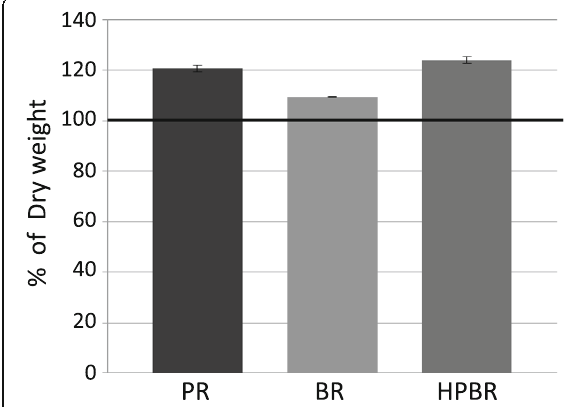
Fig. 1 Comparison of water absorbency. PR: polished rice, BR: brown rice, HPBR: highly water pressurized brown rice. Mean ± SD, n = 3